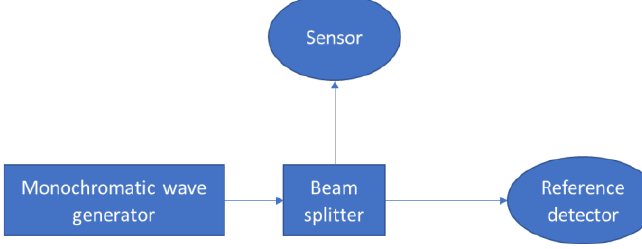
Figure 4. The measurement setup for optical characterization.